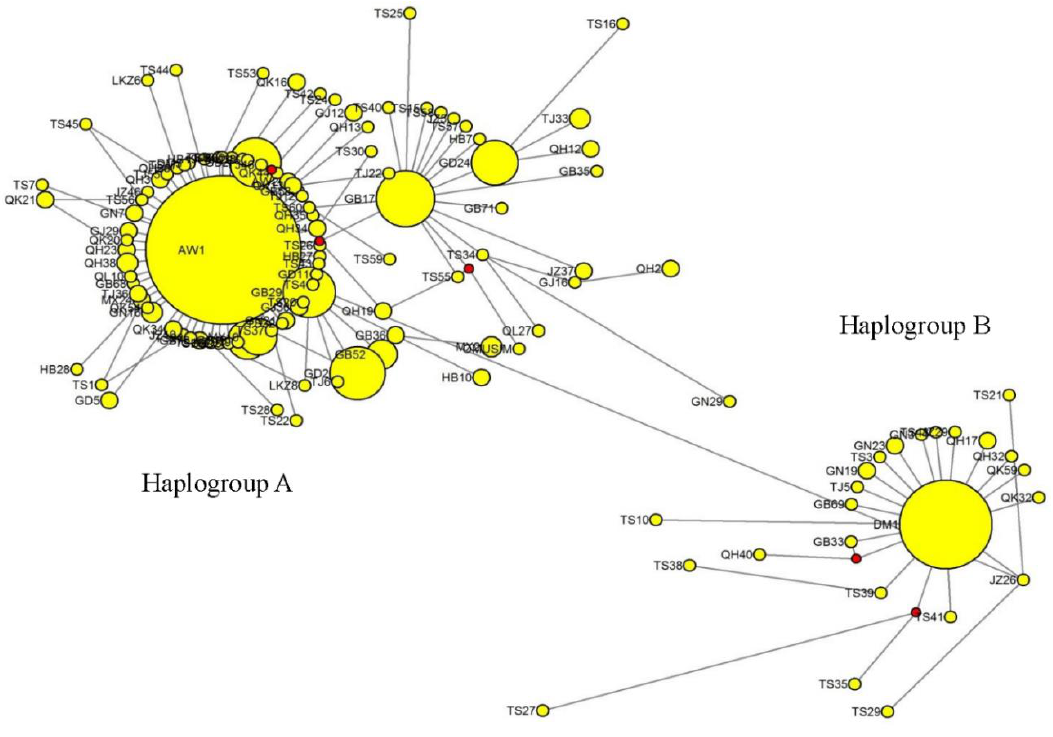
Figure 1. Median-joining networks for the MT-CYB in 641 individual from 15 Tibetan sheep populations. The haplogroup A consisted of 560 individuals and 175 haplotypes; Haplogroup B consisted of 81 individuals and 39 haplotypes.